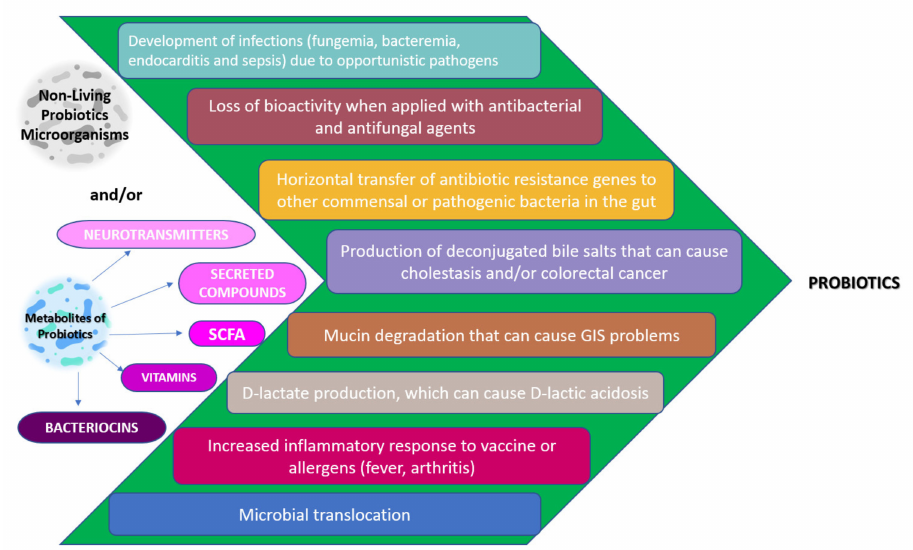
Figure 3. Some disadvantages of probiotics for microbiota and immune